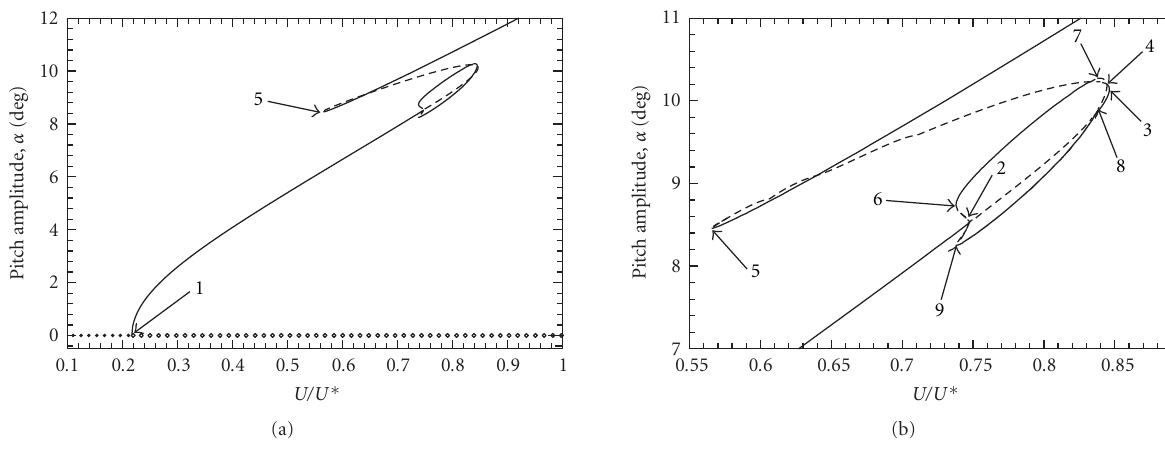
Figure 3: (a) Bifurcation diagrams showing both stable and unstable solutions for pitch motion, (b) expanded view of partial region from (a). • , stable fixed point; ◦ , unstable fixed point; —, stable limit cycle; - - - , unstable limit